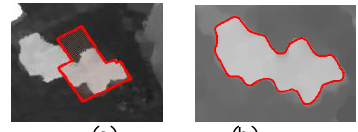
Figure 3. (a) Overlaid polygon and DSM, (b) Result of